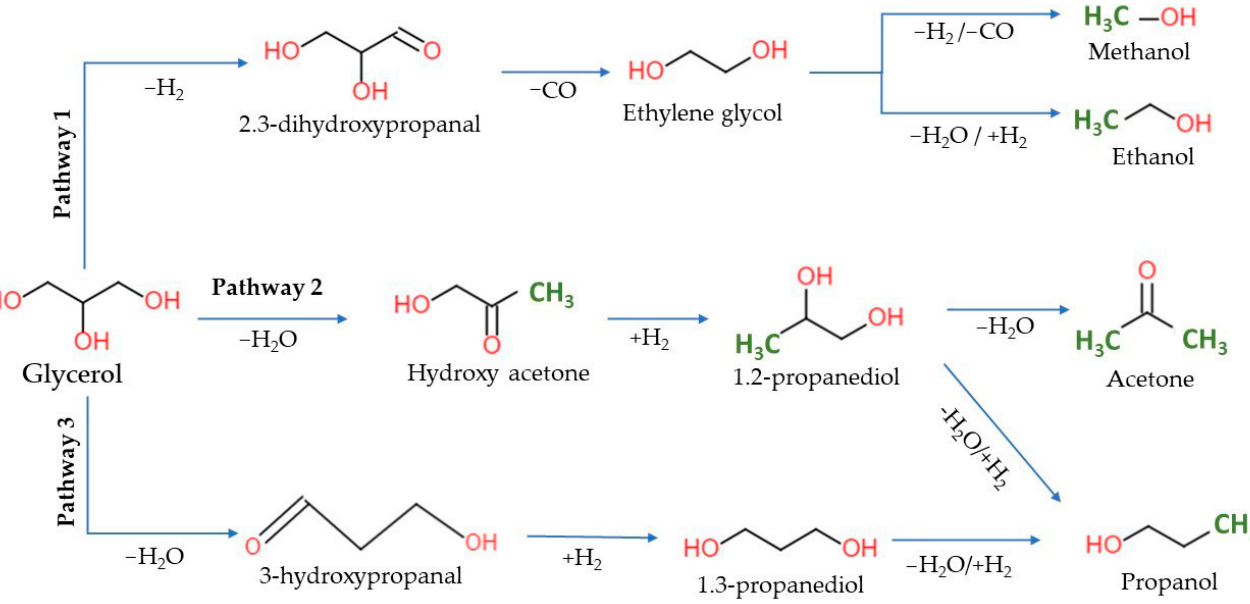
Figure 5. Possible reaction pathway during APR of glycerol as summarized by Remón, Giménez, Valiente, García and Arauzo [35]. − H 2 /+H 2 = dehydrogenation/hydrogenation; − H 2 O = dehydration; − CO = decarbonylation.